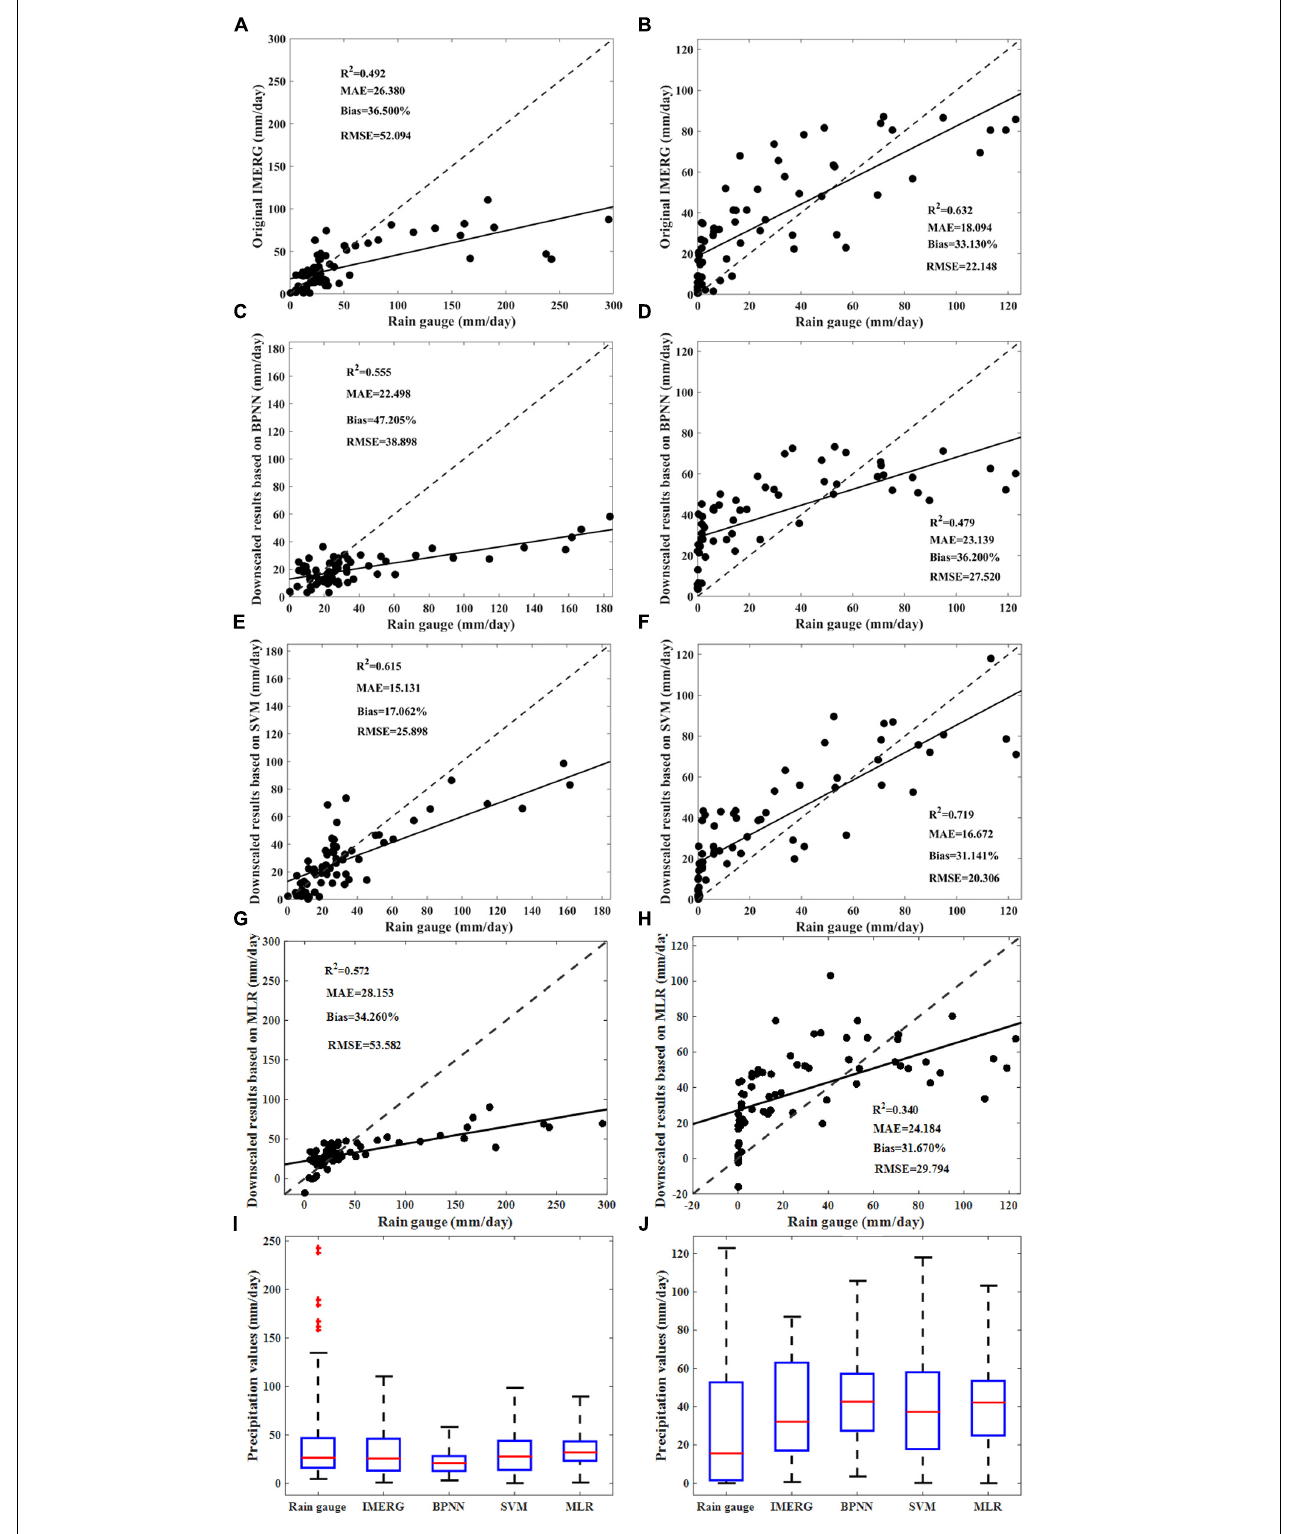
FIGURE 6 | Validations and comparisons of (A,B) the original IMERG in event 2 and event 4, (C,D) downscaled results by BPNN in event 2 and event 4, (E,F) downscaled results by SVM in event 2 and event 4, (G,H) downscaled results by MLR in event 2 and event 4 against ground observations, and (I,J) boxplots of the five precipitation datasets in event 2 and event 4 over Zhejiang